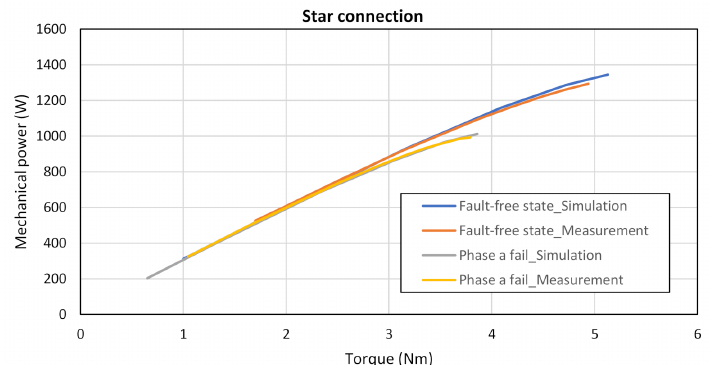
Figure 28. The dependence of the mechanical power on the torque for a fault-free state and one phase failure in the star connection.